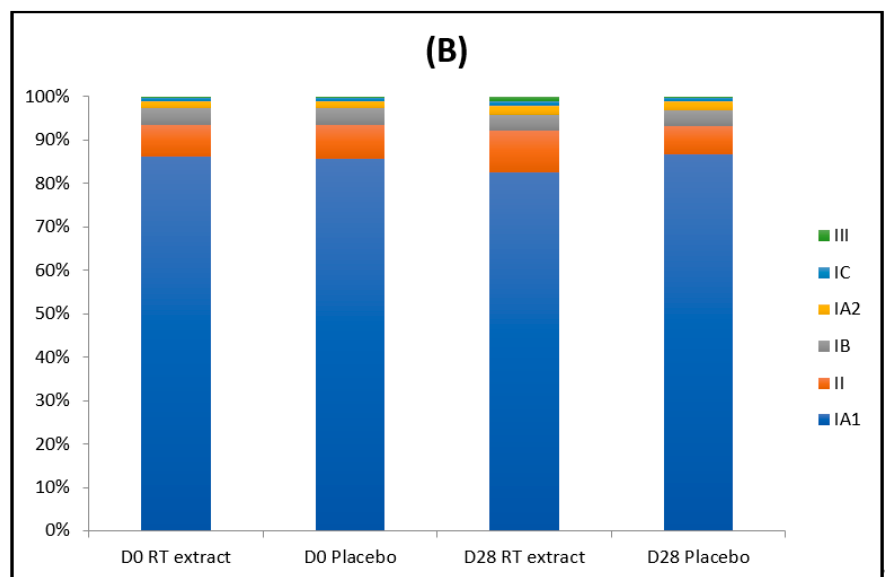
Figure 2. ( A ) C. acnes single-locus sequence typing (SLST) type distribution on placebo at D0 (before treatment) and after 28 days of placebo or RT treatment. ( B ) C. acnes phylotype distribution on